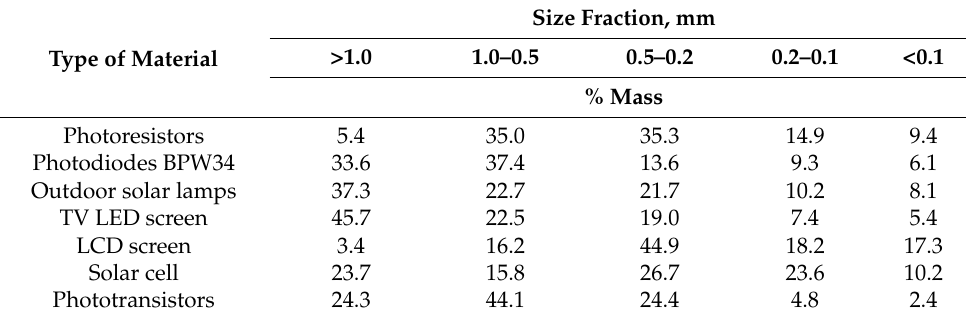
Table 3. The distribution of individual grain fractions in the ground